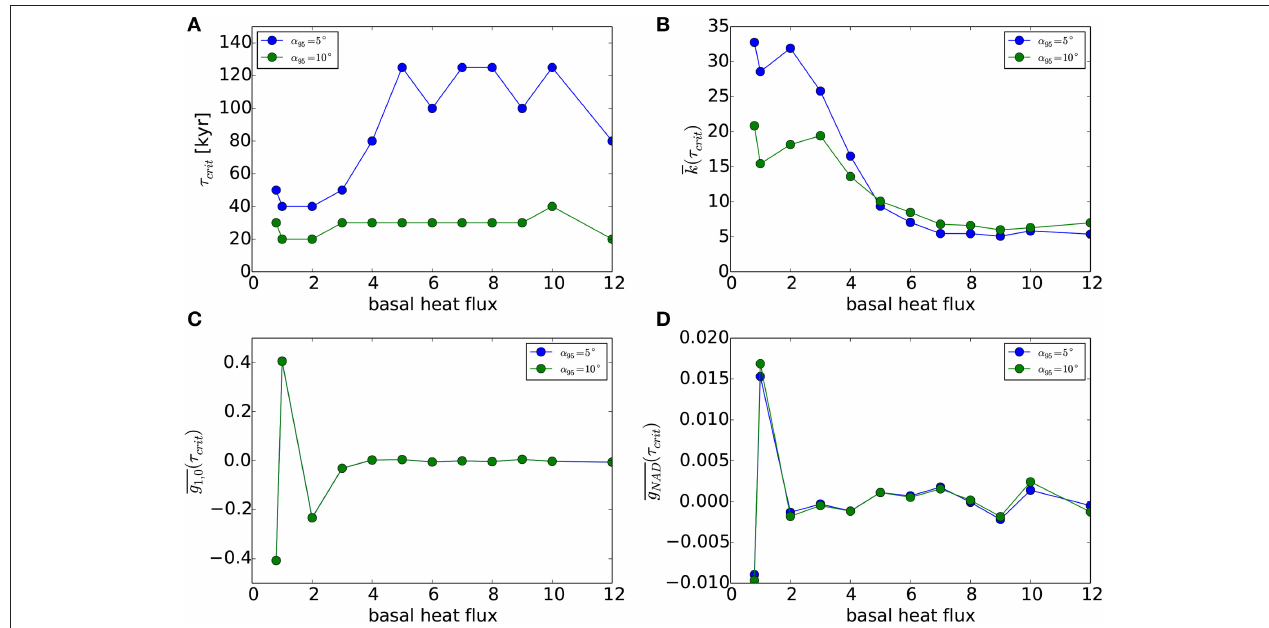
FIGURE 6 | (A) Comparison of critical running average length τ crit where α 95, crit < 5 ◦ or 10 ◦ for all models. (B) Same for Fisher’s k ( τ crit ) parameter, (C) g 1,0 ( τ crit ), and (D) g NAD ( τ crit ), where τ crit at each basal heat flux is from (A)